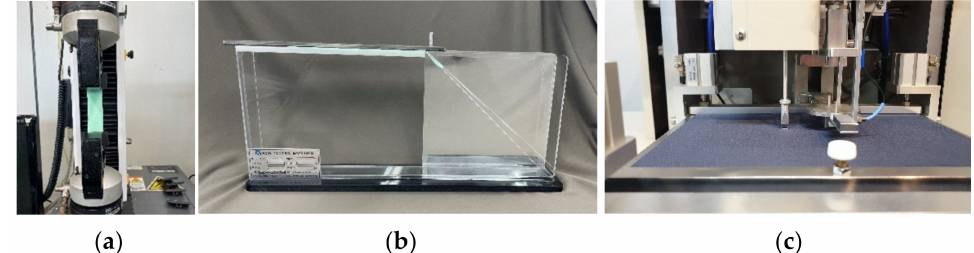
Figure 3. Images for mechanical testing: ( a ) extension test machine; ( b ) fixed-angle bending tester; ( c )